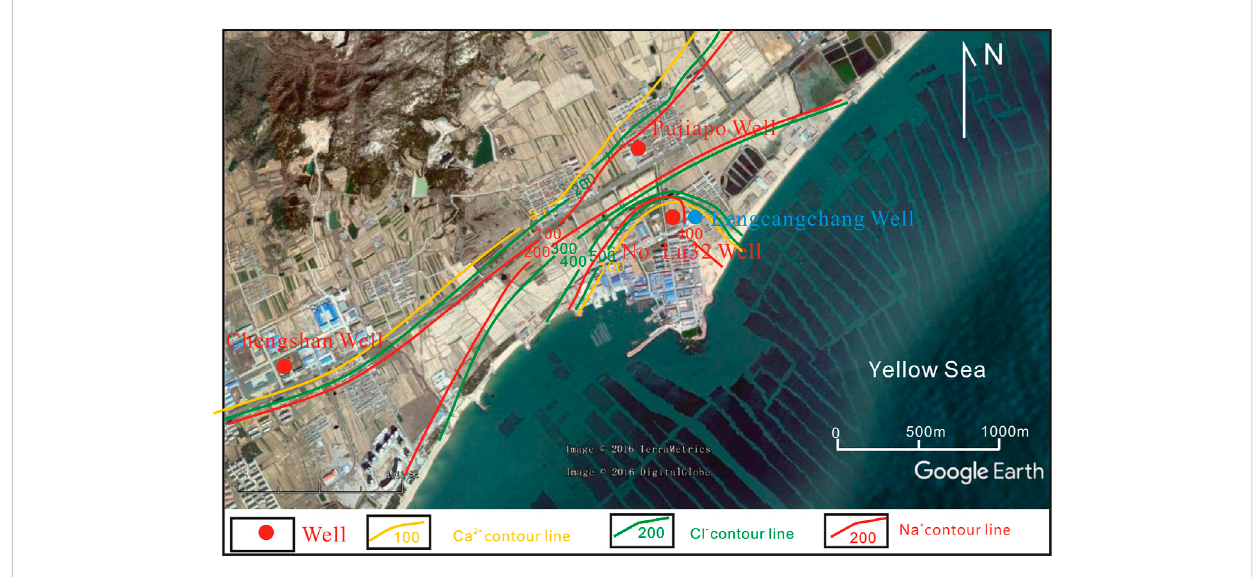
FIGURE 2 Location and distribution of the ion contours of the No. Lu 32 well and surrounding wells (sampling period: April